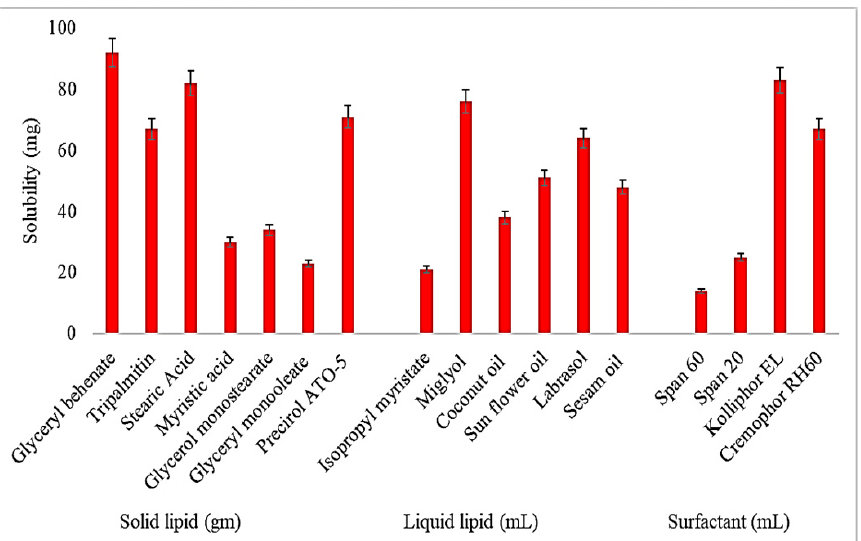
Figure 1. Solubility profile of Azithromycin in different lipids (solid and liquid) and surfactants. Study performed in triplicate and results shown as mean ± SD.